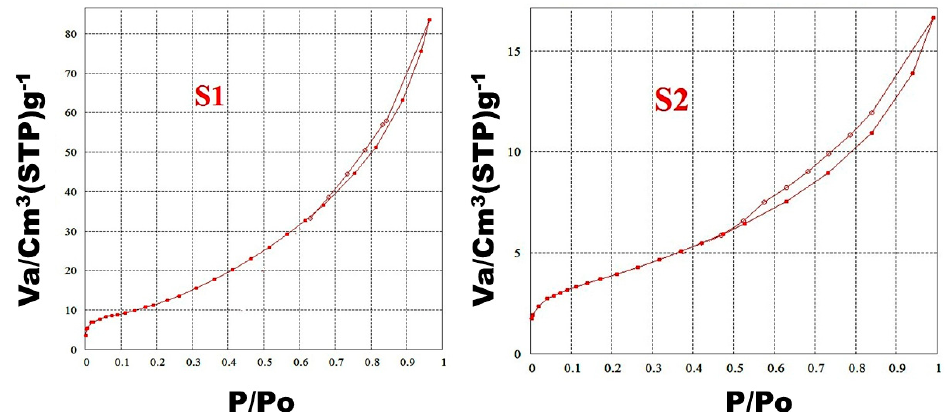
Figure 4. N 2 -adsorption/desorption isotherms of S1 and S2 samples.